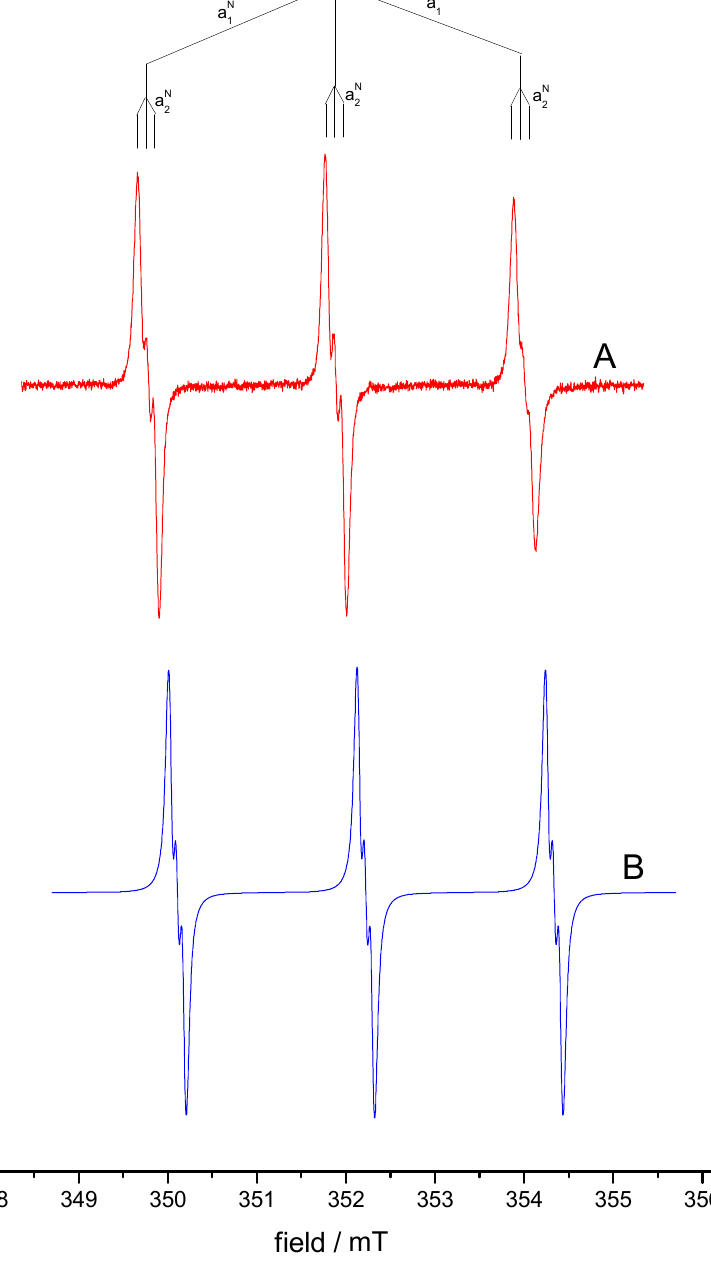
Figure 10. ESR spectra of the radical dianion: experimental ( A ) (room temperature, DMF/Bu 4 NClO 4 /Bu 4 NOH) and simulated isotropic spectrum ( B ) triplet of triplets (g i = 2.0059, 𝑎 (cid:2869)(cid:3015) (spin = 1) = 2.12 mT, 𝑎 (cid:2870)(cid:3015) (spin = 1) = 0.7 mT, LW = 0.065 mT, L/G = 0.1). The isotropic spectrum of the radical dianion recorded at room temperature was a triplet of triplets—three equidistant lines by splitting on the nitrogen (spin = 1) of the NO 2 group ( 𝑎 (cid:2869) (cid:3015) = 2.12 mT), with each of them split by a small constant ( 𝑎 (cid:2870) (cid:3015) = 0.7 mT) on the nitrogen (spin = 1) in position 4 of the heterocycle. Calculated using the DFT level of theory (PBE0/def2-TZVPP), the hyperfine coupling constants for the dianion radical of 1A—g i = 2.0057, 𝑎 (cid:2869)(cid:3015) (NO 2 group) = 2.28 mT, and 𝑎 (cid:2870)(cid:3015) (N in the 4 position of the heterocycle) = 0.44 mT—were in agreement with the experiment. The ESR spectra of the adducts of the TEMPO spin trap with the reduction product 1a are additional evidence of the structure of the radicals formed during the ER of 1a (Fig- ure S7 in the Supplementary Materials). The obtained ESR spectrum can be described as a superposition of the ESR spectra of two adducts; in one adduct, the center of the inter- action of the spin trap with the supposed radical is the nitro group, and in the second, the center is the nitrogen atom in position 4 of the six-membered heterocycle.